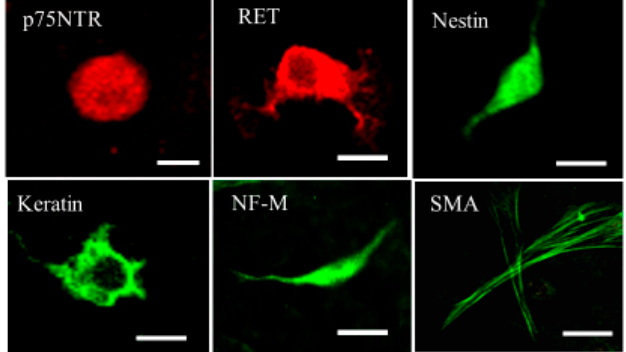
Figure 3. Immunofluorescent images of naïve ADMSCs. p75NTR, p75 neurotrophin receptor, a mesenchymal precursor marker; RET, ret proto-oncogene product, an endodermal precursor marker; nestin, a neural progenitor marker; keratin, an epidermal stem cell marker; NF-M, neurofilament-M, a neuron marker; SMA, smooth muscle actin, a smooth muscle cell marker. Fluorescein isothiocyanate (FITC), green; rhodamine, red. Scale bar = 10 μ m.